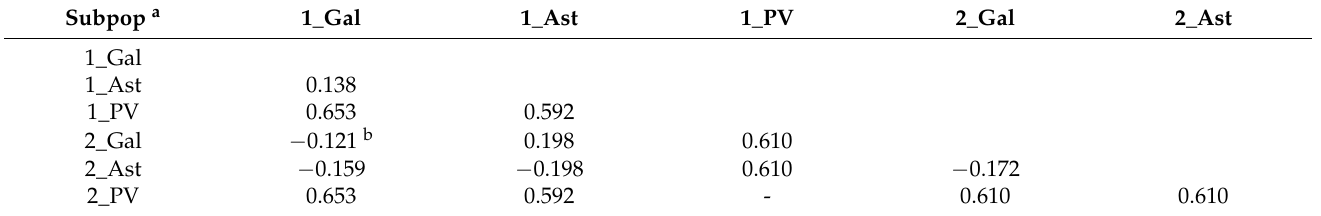
Table 6. Pairwise standarized Hendrick’s index (G’ st ) of genetic diversity (2005) in Fusarium circinatum (clone-corrected) between Spanish populations defined in a temporal scale and by geographic